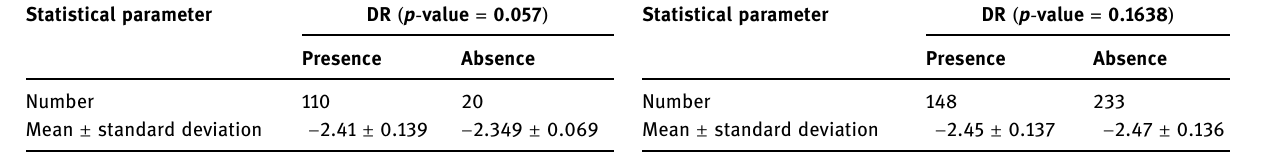
Table 1: Standard deviation and mean for DR in DIARETDB - 0 Statistical parameter